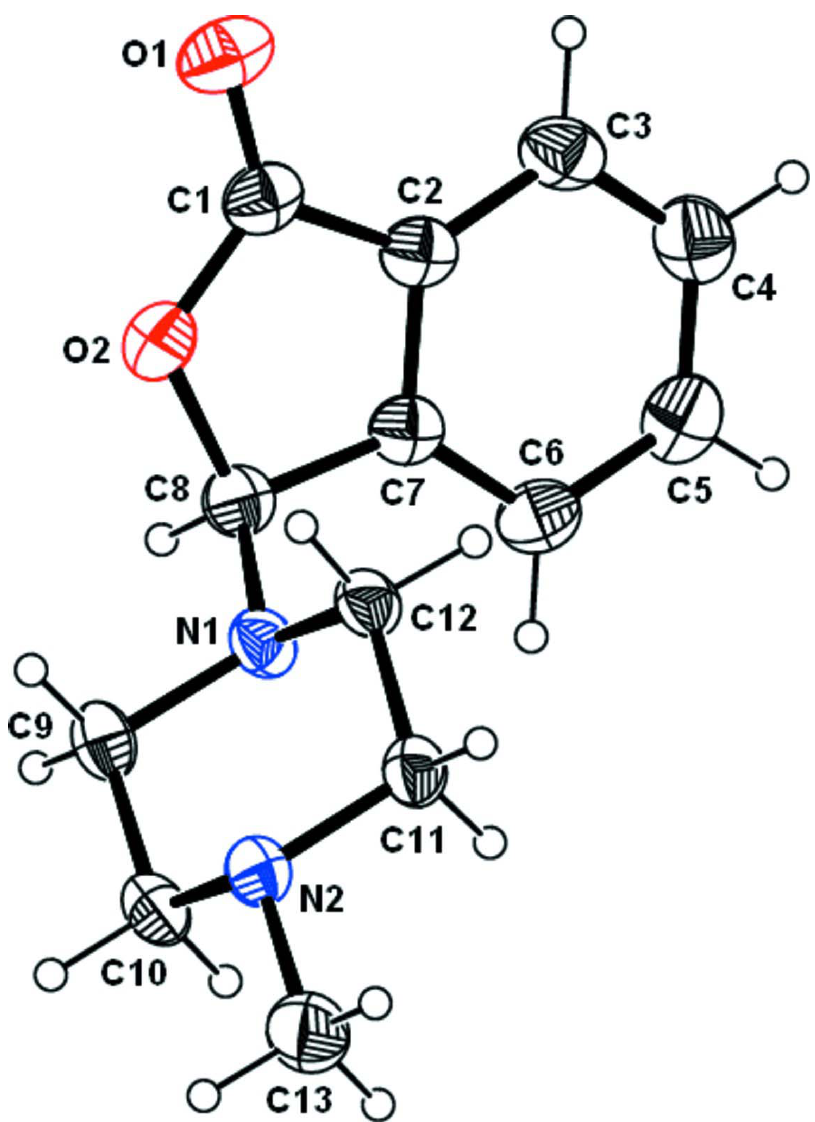
Figure 1 The molecular structure of the title molecule, with the atom-numbering scheme. Displacement ellipsoids are drawn at the 30% probability